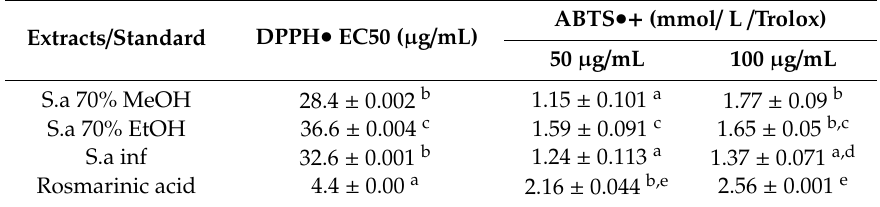
Table 2. DPPH • and ABTS • + radical scavenging activities of S. aramiensis